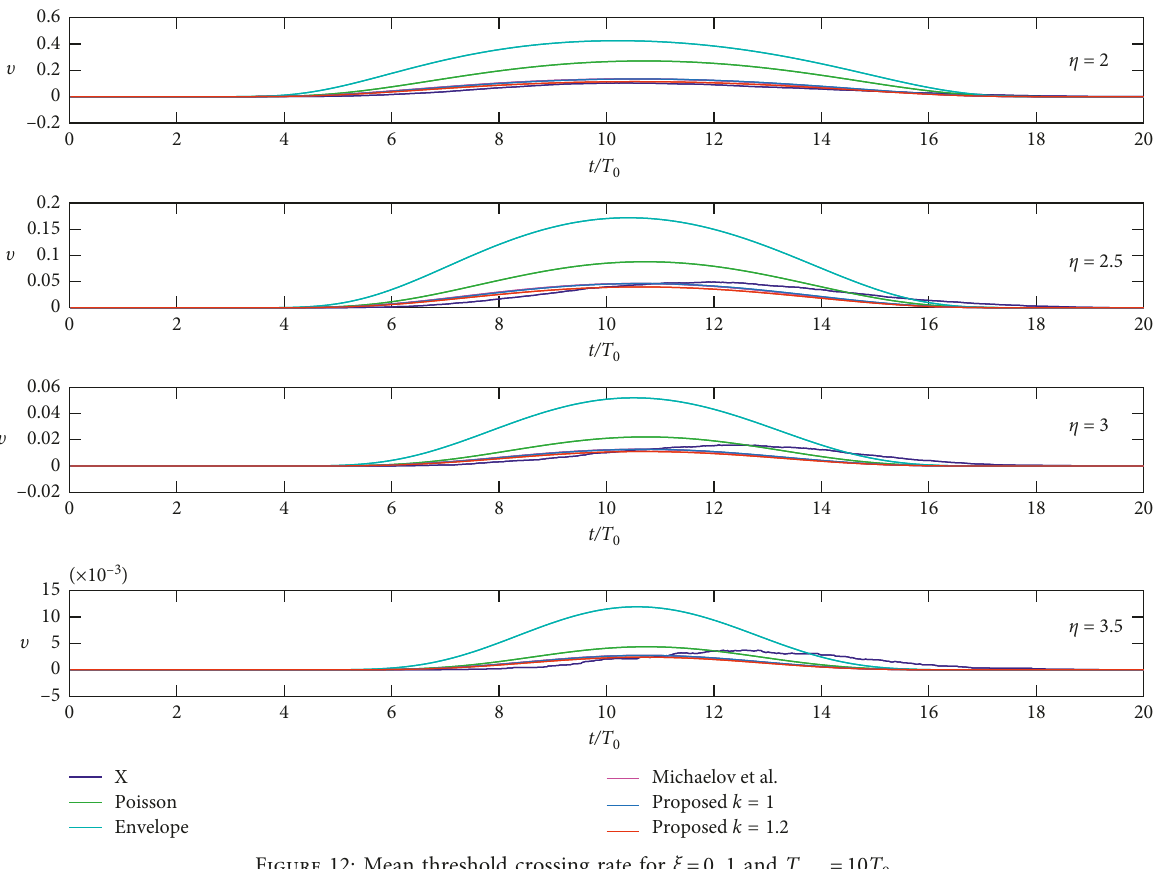
Figure 12: Mean threshold crossing rate for ξ � 0. 1 and T